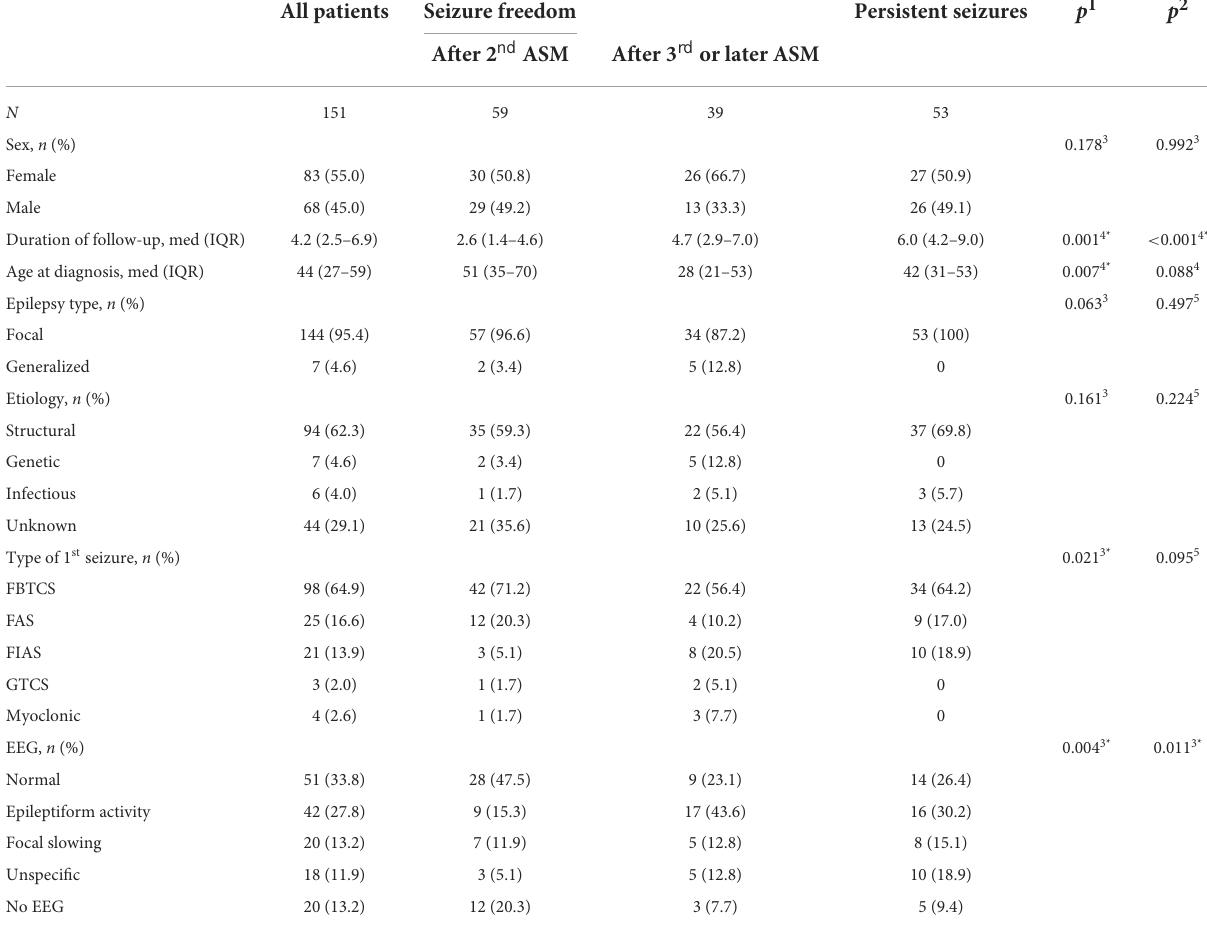
TABLE 2 Background characteristics (median and interquartile range or frequency and percentage) at the last clinic visit for all patients with epilepsy who did not become seizure-free following administration of the first antiseizure medication. All patients Seizure freedom Persistent seizures p 1 After 2 nd